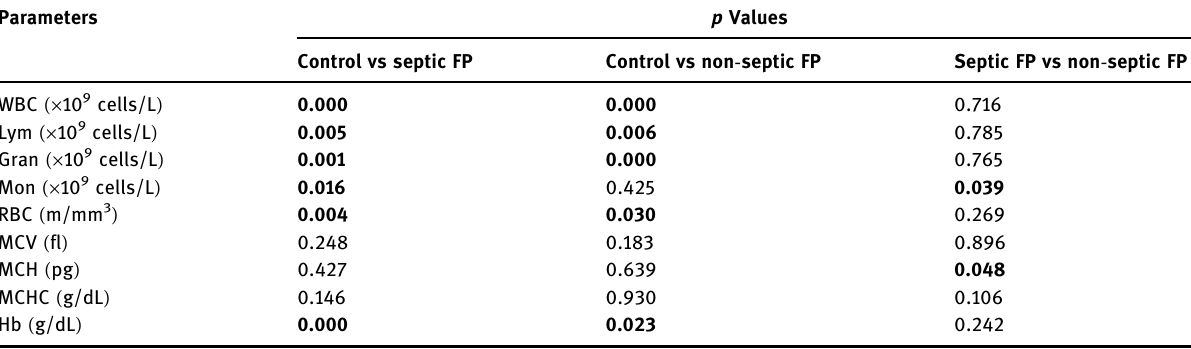
Table 5: p Values of intergroup comparison of hemogram analysis results ( p < 0.05: bold